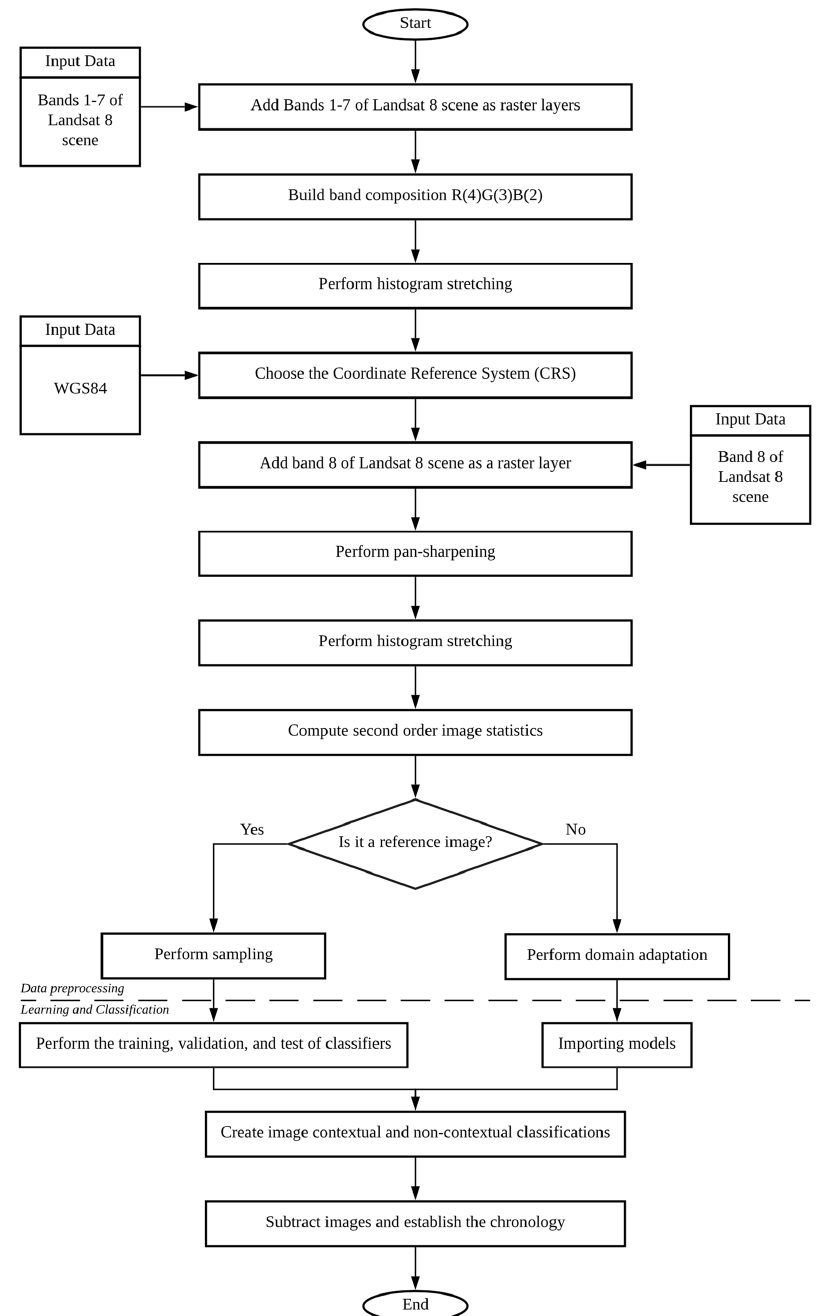
Figure 1. Flowchart of the proposed anomaly detection strategy, which is based on Kittler’s taxonomy. The border between the data preprocessing, learning, and classification approaches are set out in the figure. The adopted coordinate reference system (CRS) uses the WGS84 geodetic reference frame and the universal transverse mercator (UTM) map projection. Geographical features, such as rivers, lakes, waterways, artificial reservoirs, clouds, shadows of clouds, plantations, forests, fields, cities, and highways, are selected by the user (under input data) as samples. Landsat 8 band used, wavelength, and resolution: Band 1—coastal aerosol (0.43–0.45 µ m) 30 m; Band 2—blue (0.45–0.51 µ m) 30 m; Band 3—green (0.53–0.59 µ m) 30 m; Band 4—red (0.64–0.67 µ m) 30 m; Band 5—near infrared (NIR) (0.85–0.88 µ m) 30 m; Band 6—SWIR 1 (1.57–1.65 µ m) 30 m; Band 7—SWIR 2 (2.11–2.29 µ m) 30 m, and Band 8—panchromatic (PAN) (0.50–0.68 µ m) 15